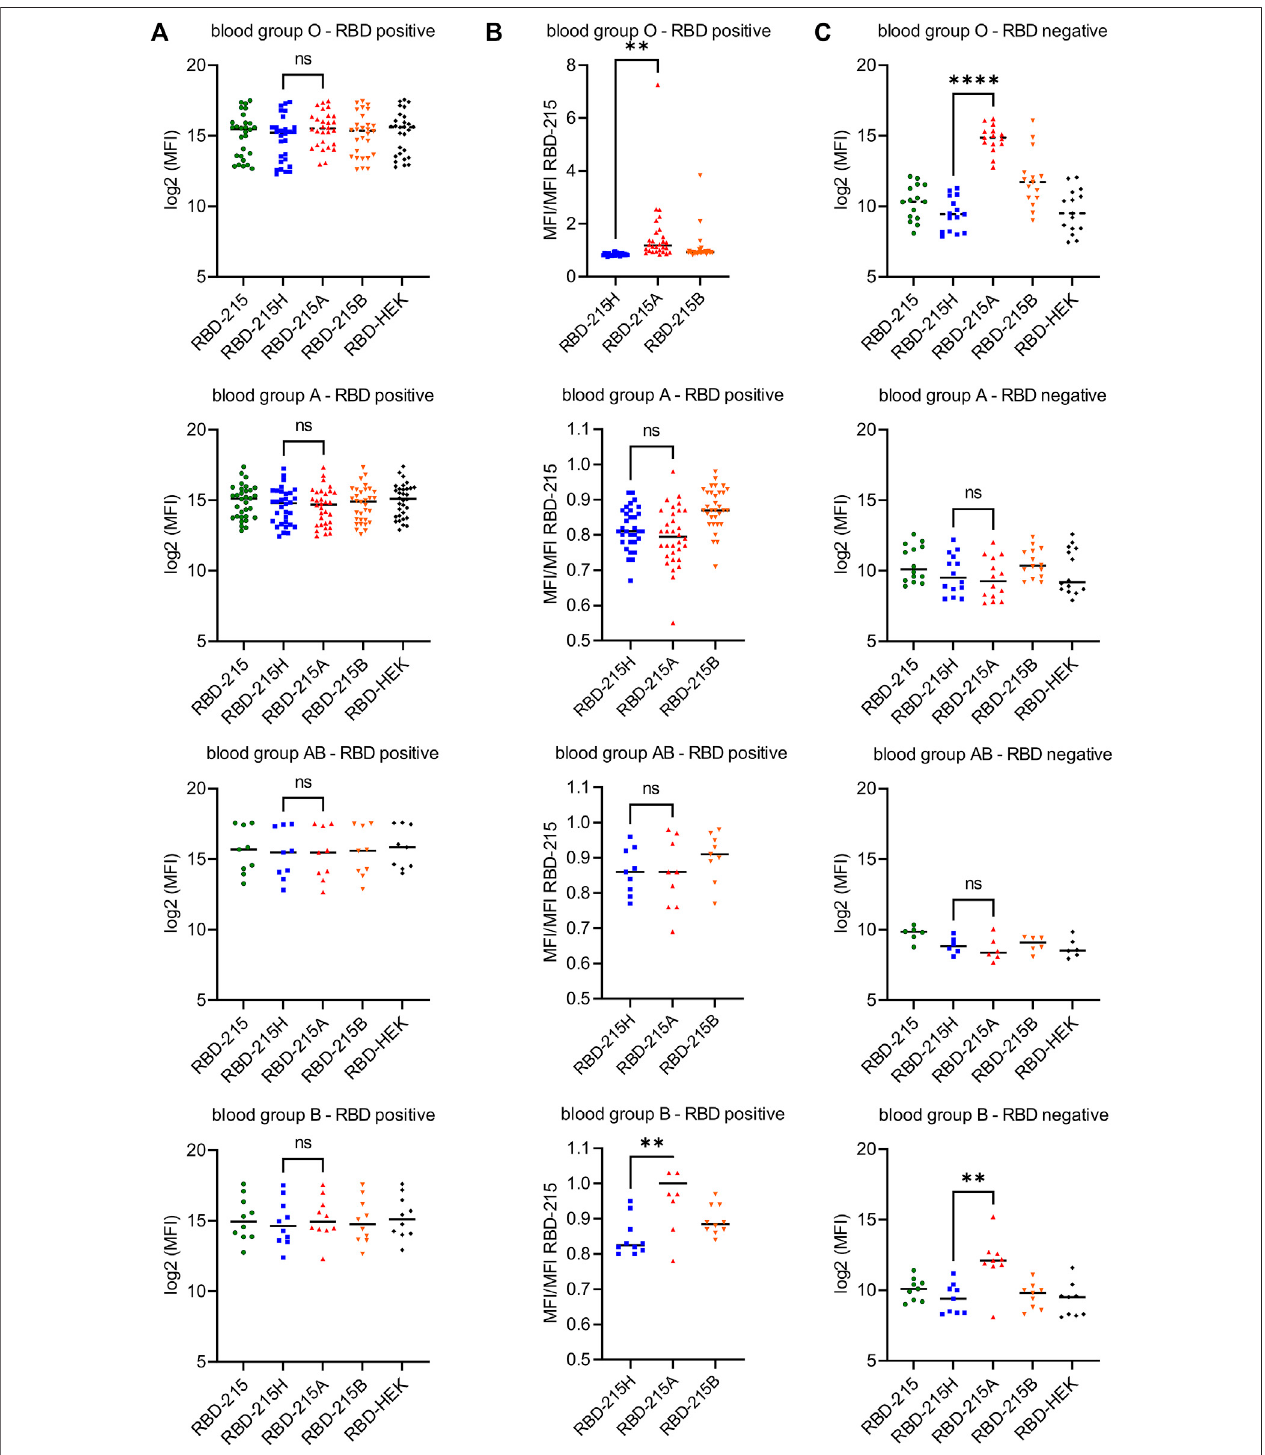
FIGURE 8 | Sera from blood group O and B individuals react strongly with RBD-215A carrying blood group A antigens in a multiplex bead-based assay. (A) Reactivity of con fi rmed RBD positive sera (according to the WHO standard) to different RBD-215 glycoforms. RBD produced in HEK293 cells (RBD-HEK) was included for comparison. The line depicts the median in each group. A student ’ s t-test was used to compare the reactivity to RBD-215H (carrying the H antigen) and RBD-215A (carrying the A type 2 antigen). “ n.s. ” not signi fi cant; “ ** ” p < 0.01; “ **** ” p < 0.0001. Blood group O ( n (cid:1) 28), blood group A ( n (cid:1) 32), blood group AB ( n (cid:1) 9), blood group B ( n (cid:1) 10). (B) MFI values were normalized to the MFI values for RBD-215. The line depicts the median. A student ’ s t-test was used to compare the normalized values of RBD-215H and RBD-215A. (C) Reactivity of con fi rmed RBD negative sera (according to the WHO standard) to different RBD-215 glycoforms and RBD-HEK. Blood group O ( n (cid:1) 15), blood group A ( n (cid:1) 14), blood group AB ( n (cid:1) 6), blood group B ( n (cid:1) 9).